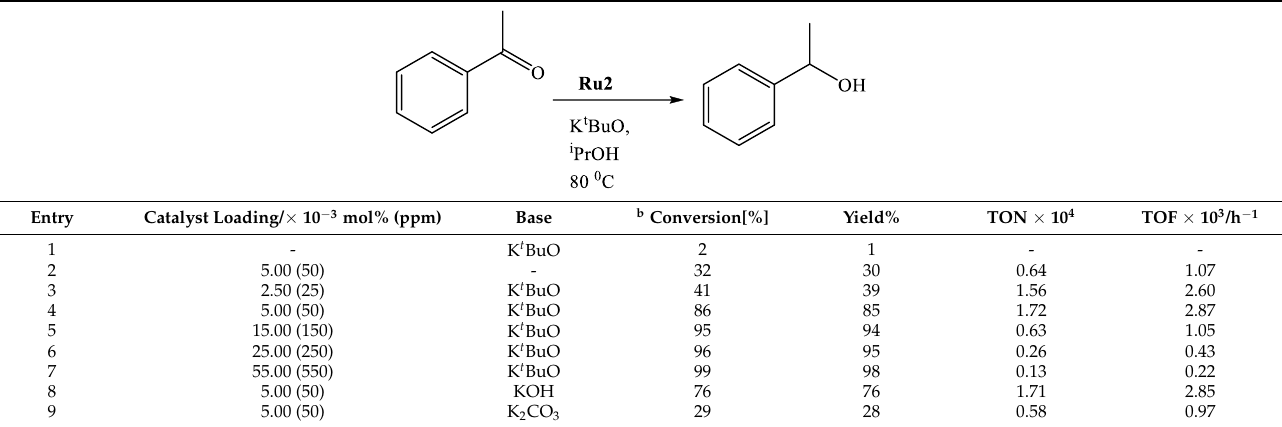
Table 2. Effects of catalyst concentration and base on transfer hydrogenation of acetophenone using complex Ru2 as a catalyst a .